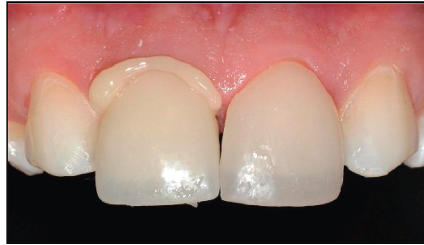
Figure 15: Extravasation of the cementing agent in element 11.